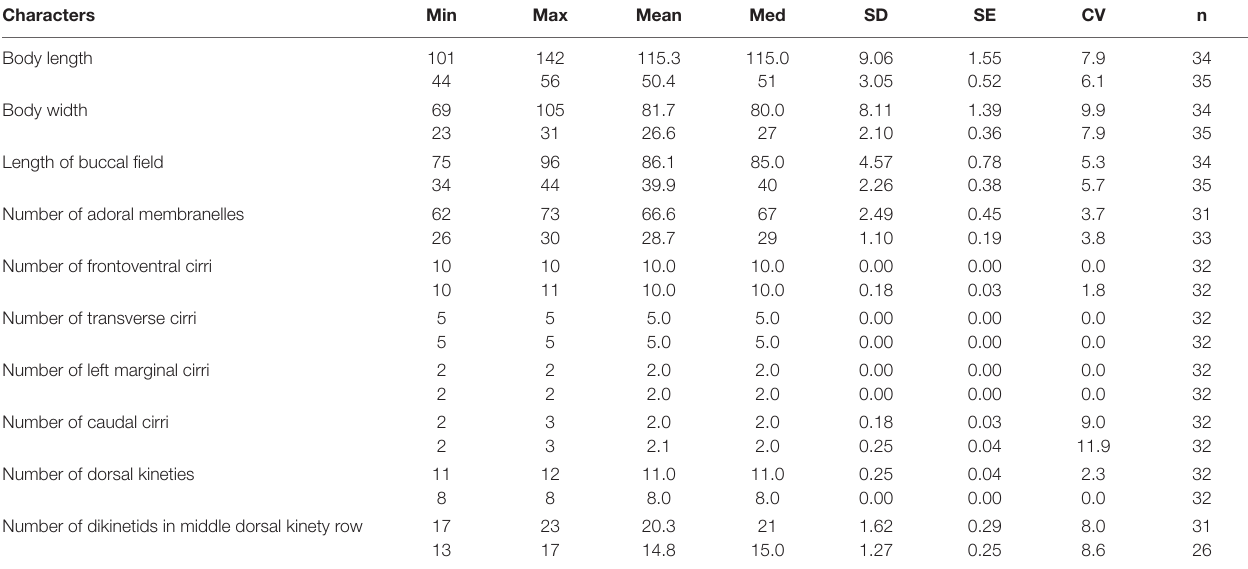
TABLE 1 | Morphometric characteristics of Euplotes neapolitanus (upper rows) and E. antarcticus (lower rows) from protargol impregnated specimens. Characters Min